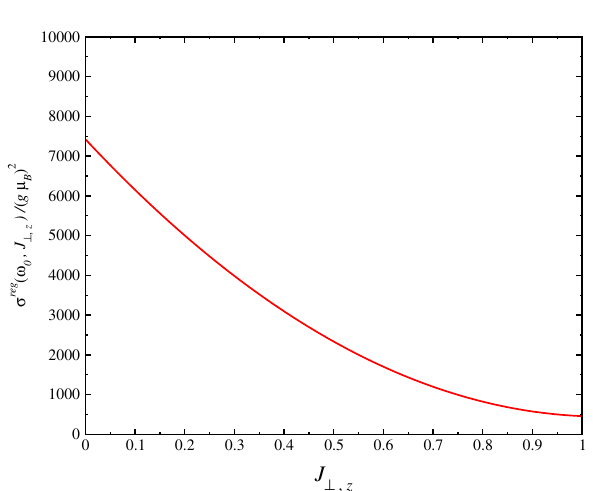
1.0 and J 2 0.2 . We perform the calculations for a = − = 2 should be put in case of 0.03 . The factor ( g µ ω p B ) = ≈